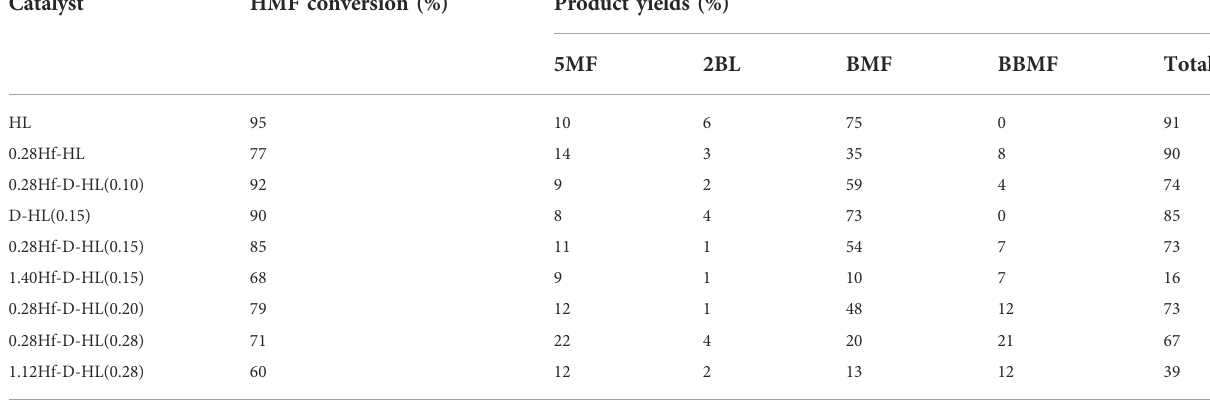
TABLE 2 Performance of the prepared catalysts in the reaction of 5-(hydroxymethyl)furfural (HMF). a